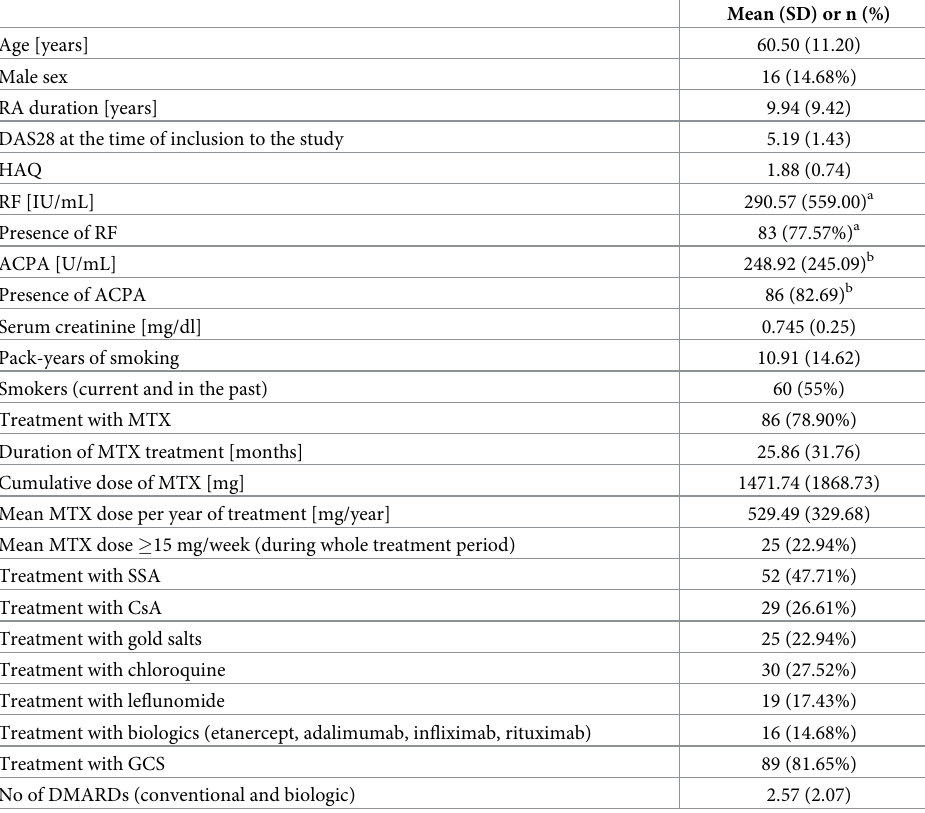
Table 1. Study group